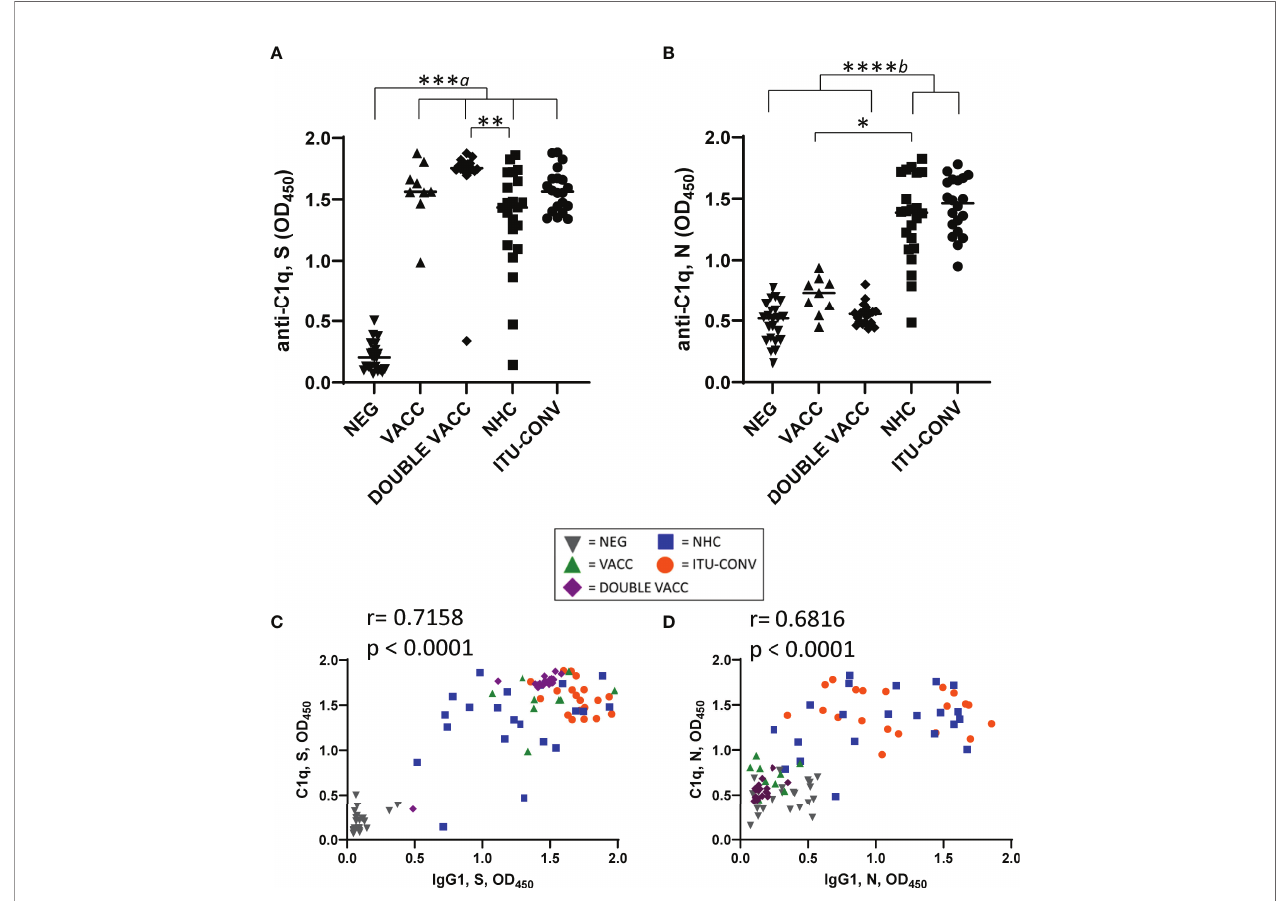
FIGURE 2 | C1q binding to S and N correlates with IgG1 responses. Using an ELISA against 0.1ug S (A) or N (B) with an anti-C1q secondary antibody, followed by an HRP-conjugated tertiary, and the ELAST ampli fi cation kit, C1q binding was measured. Correlations of IgG1 OD and C1q OD against S (C) and N (D) . NEG, n = 22. VACC, n = 9. DOUBLE VACC n = 19. NHC, n ≥ 21. ITU-CONV n = 20. Kruskal-Wallis with Dunn ’ s multiple comparisons test was used. a indicates that the four groups bracketed were individually signi fi cantly different to the NEG group; b indicates that NHC and ITU-CONV are independently signi fi cantly different to NEG and DOUBLE VACC. ****p < 0.0001, ***p <0.001 **p < 0.01, *p <0.05. Bars represent median values for each group. Correlations were determined using the Spearman ’ s rank correlation test (r and p values